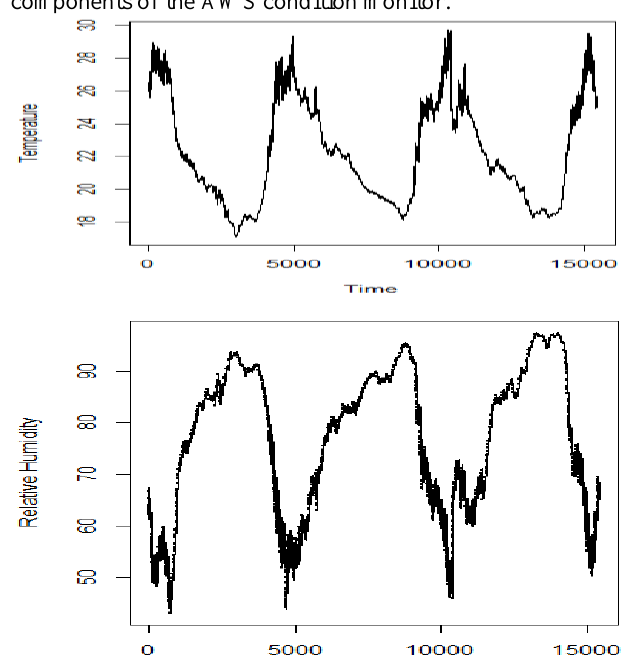
Figure 7 . Web visualization of relative humidity and temperature over time to assist in real-time observations of the correlations of the two parameters.